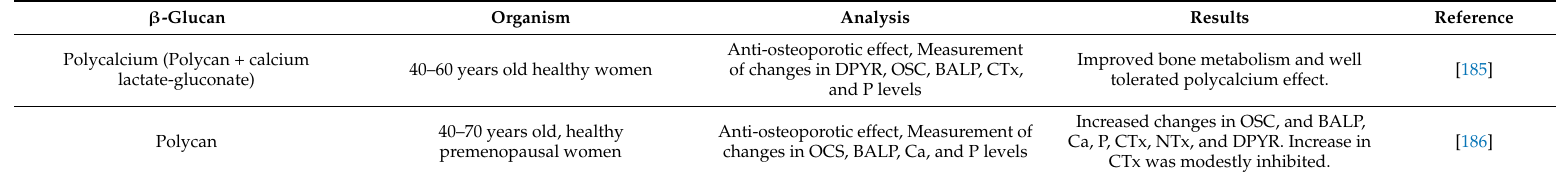
Table 10. Bone regeneration/bone injury healing effects of β -glucans—human